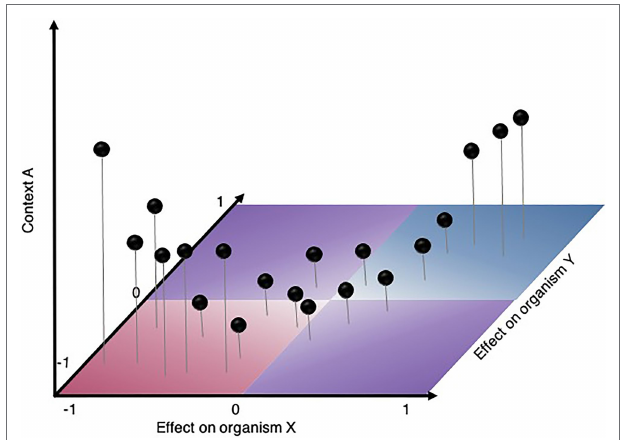
FIGURE 3 | Hypothetical scenario illustrating how experimentally mapping binary interactions at high throughput on a range of phenotypes (X- and Y-axis) and in various contexts (Z-axis) will help answer the outstanding question in microbial ecology: are there common patterns driving microbial relationship? For instance, do interactions strengthen in specific contextual gradients? Experimental approaches needed to answer such questions may vary according to the contextual gradient (e.g., time, space, level of structure, phylogenetic gradient, environmental gradient, community diversity,